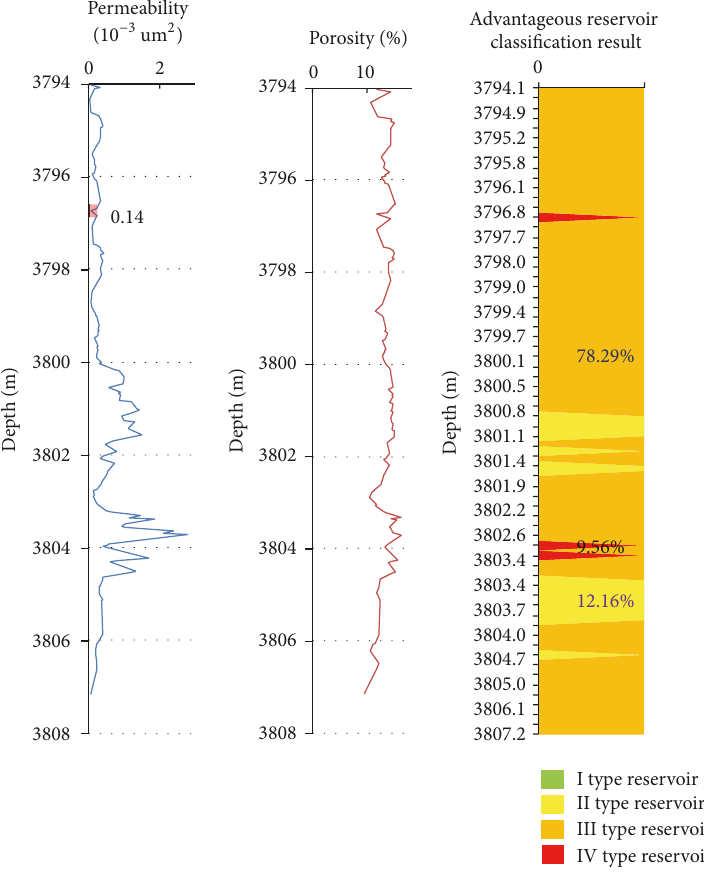
Figure 4: Comparison chart between advantageous reservoirs, porosity, and permeability. Table 2: Oil and water phase-permeability test data of three types of